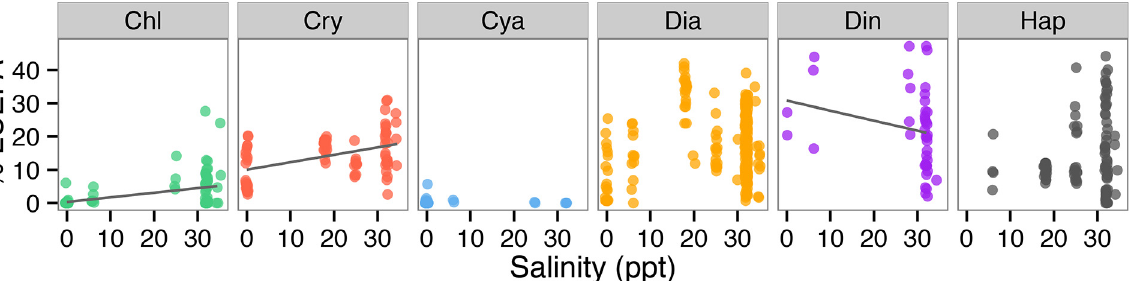
Fig 3. Phytoplankton group specific correlations between the Σ LCEFA in the % FA dataset and salinity of culture conditions. Salinity and % LCEFA was positively correlated (Kendall ’ s Tau, p < 0.001) for chlorophytes and cryptophytes, negatively correlated for dinoflagellates, and not correlated for the other groups. Group abbreviations follow Fig 1. All points within each algal group are the same color, but are plotted with semi-transparency to accommodate for over plotting of points with similar values. Separate correlations for each phytoplankton group were performed due to the larger within-group sample sizes in this dataset.